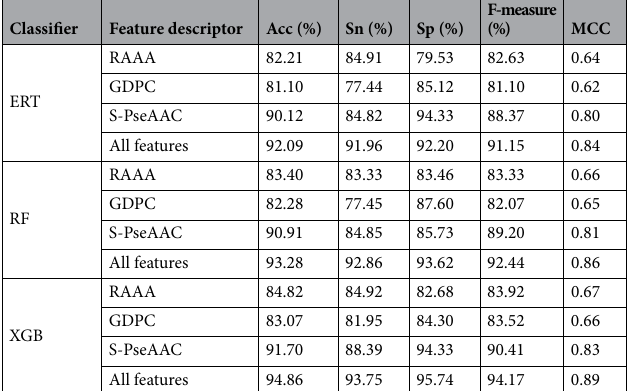
Table 3. Performance of classifiers after feature selection.